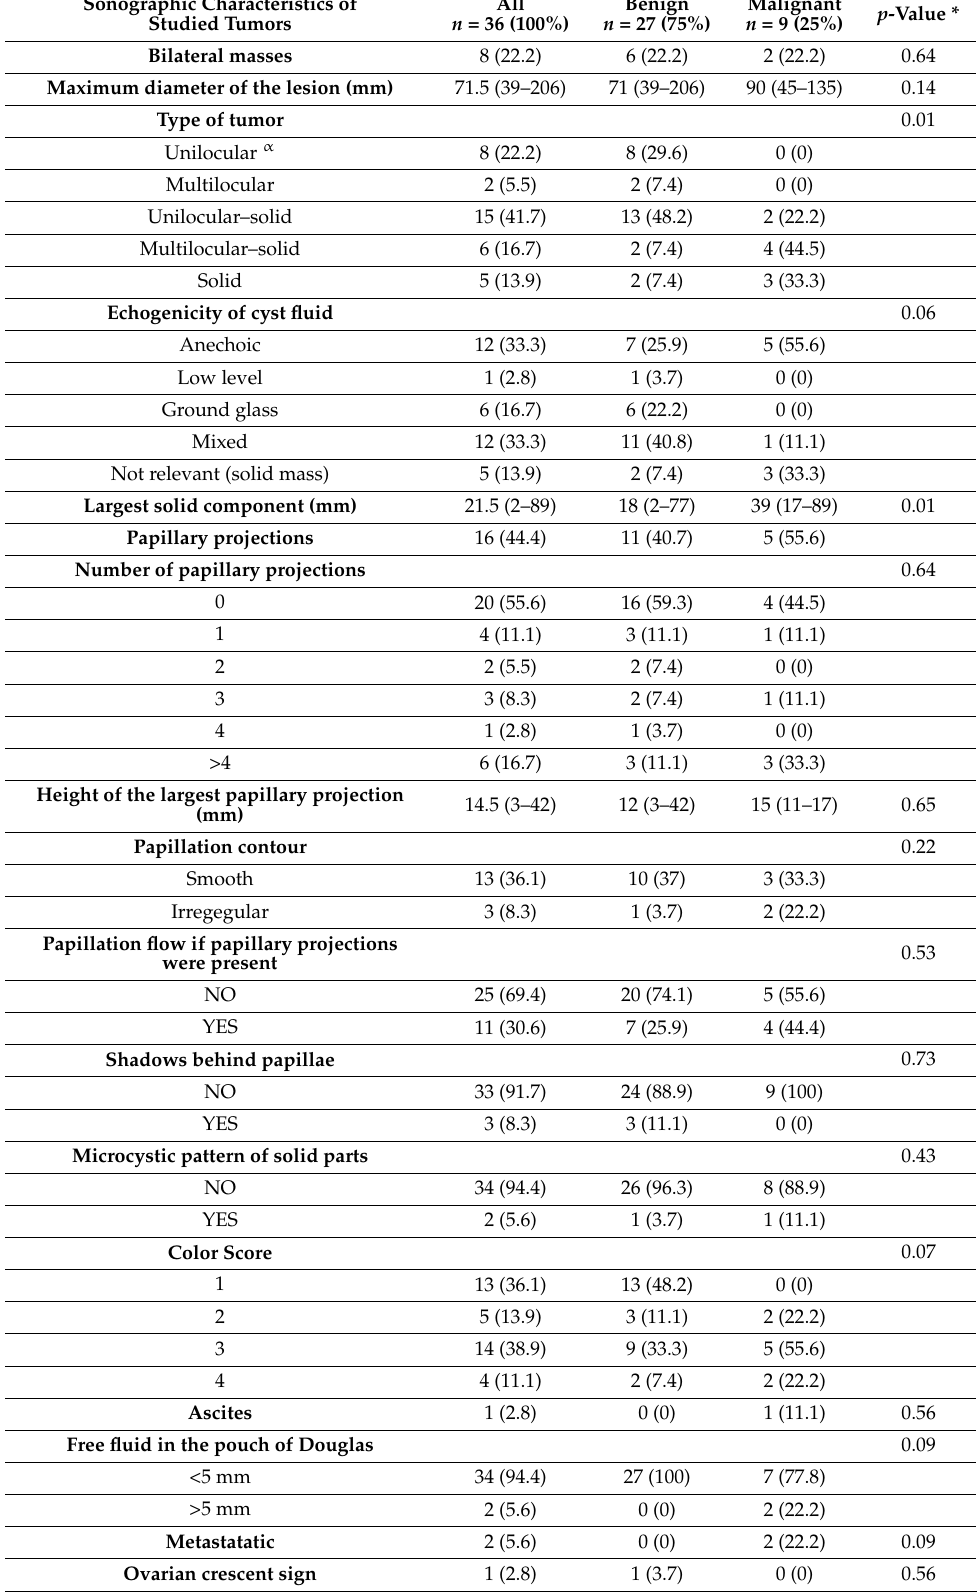
Table 3. Selected ultrasound features of the studied group of adnexal